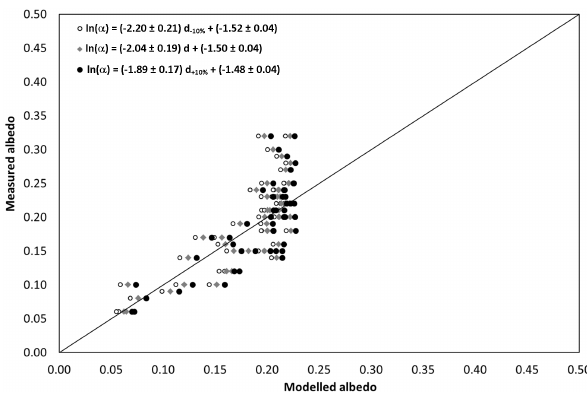
Figure 10. Comparison between measured and modeled albedo val- ues. The applied equations (Table 3) are shown in the legend.